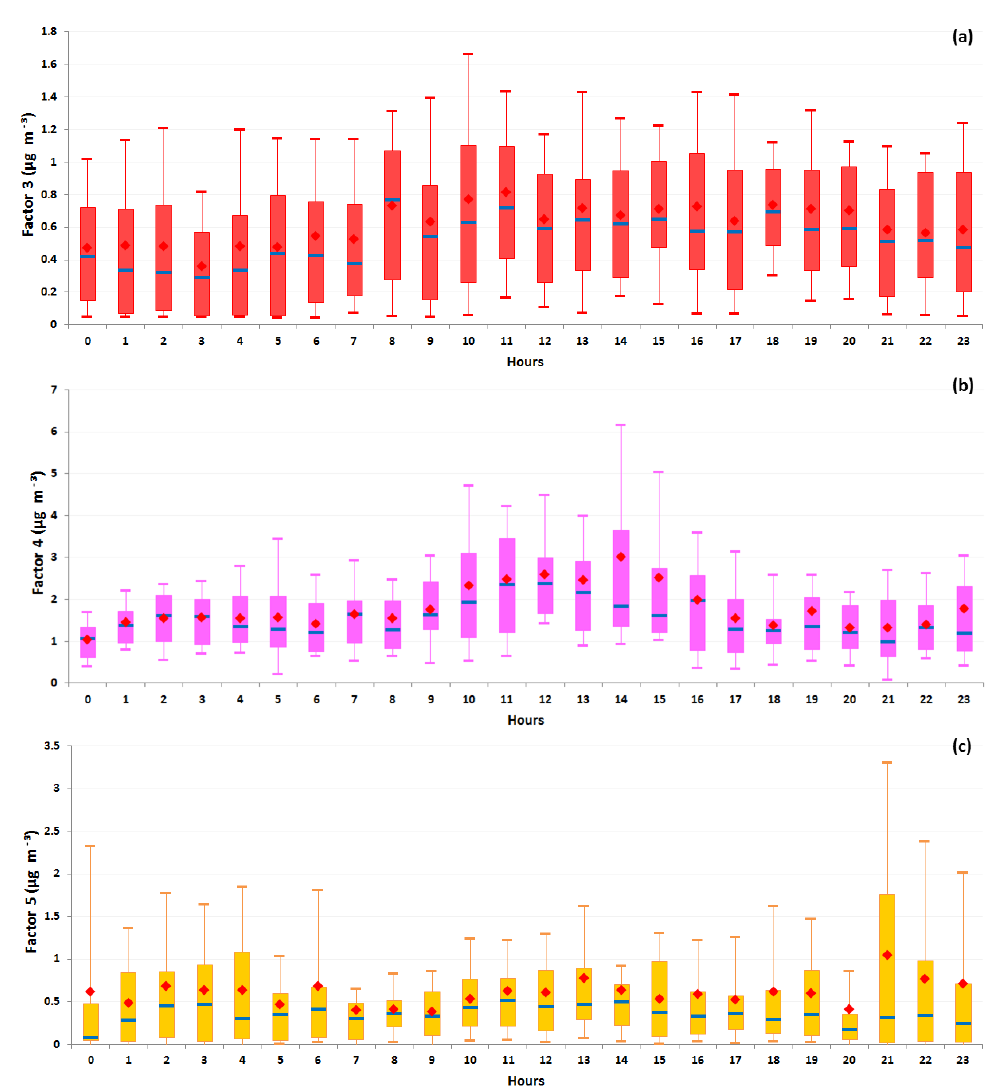
Figure 10. Diel variation in the factor contributions (a–c) represented by hourly box plots. Diurnal profiles do not include contributions obtained when the site was under the influence of air masses categorized as belonging to cluster 7. Blue solid line represents the median contribution, the red marker represents the mean contribution and the box shows the interquartile range. The bottom and the top of the box depict the first and the third quartiles (i.e., Q1 and Q3). The ends of the whiskers correspond to the first and the ninth deciles (i.e., D1 and D9). Time is given as local